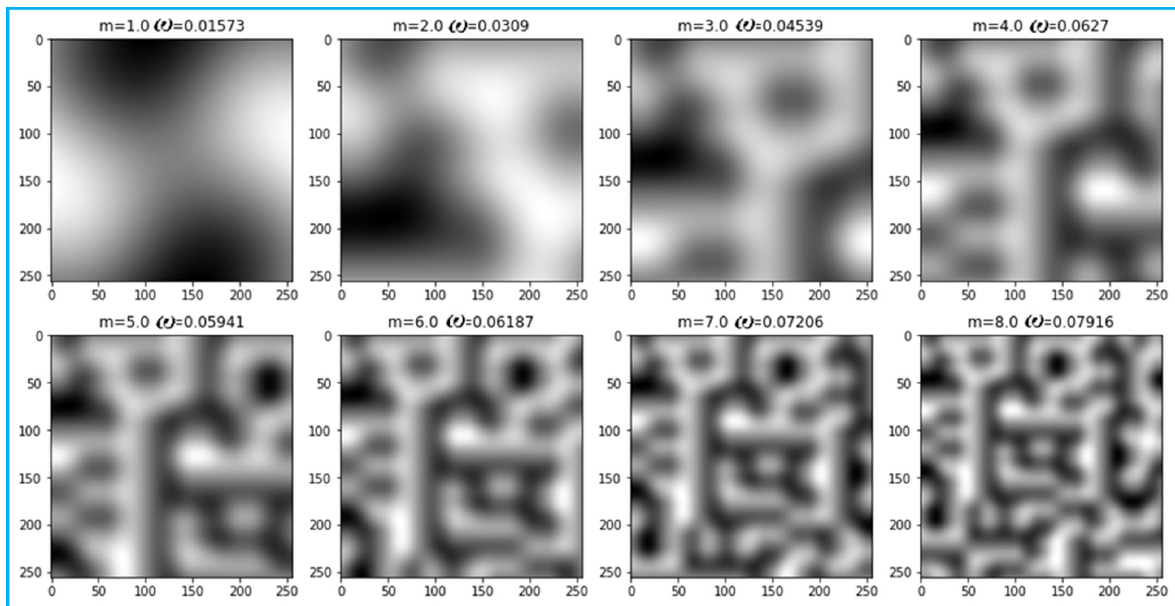
Figure 10. Perlin noise by zoom factor, m, and result analysis by Equation (9) of angular frequency, ω